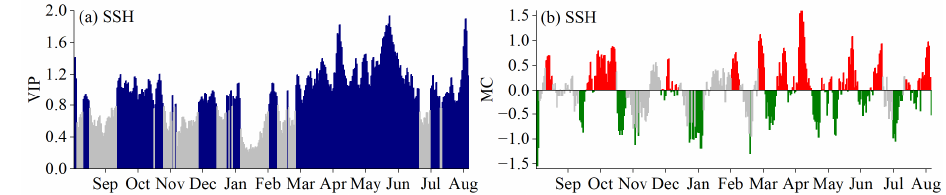
Figure 7. Results of partial least squares (PLS) regression correlating the peak of the growing season (POS) from 1985–2018 with 31-day running means of climatic factors. ( a , b ) Sunshine hours (SSH) from the previous September to August of the year.